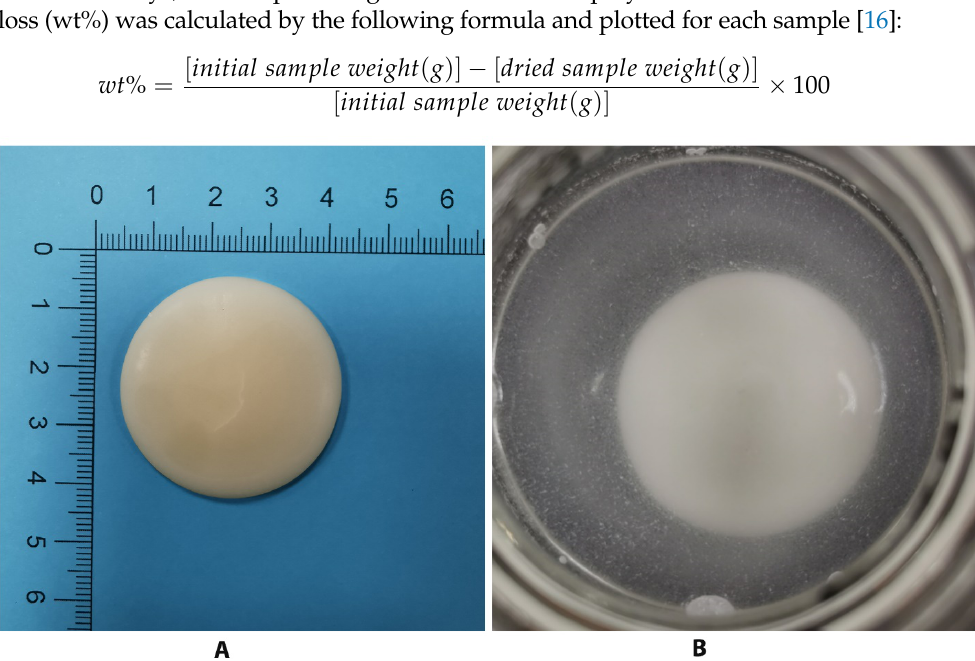
Figure 5. ( A ) Final polyanhydride sample after being melt-casted (4 mm thick) at 80 ◦ C. ( B ) The polymer submersed in buffer solution (PH: